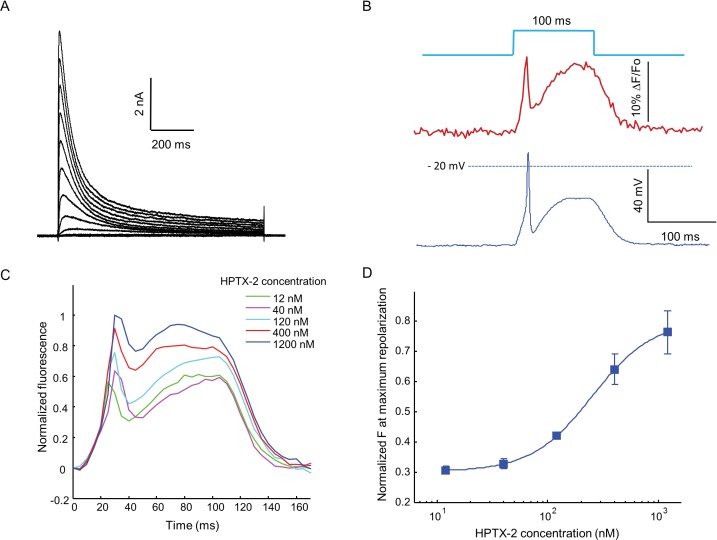
Optopatch assay of KV4.3 function.(A) Voltage clamp recording of KV4.3 current in NaV1.5-KV4.3 Optopatch HEK cells. The bath contained 30 μM TTX to block the NaV1.5 current. Cells were held at −70 mV and then subjected to 1 s steps to −60 mV to +40 mV in 10 mV increments. Peak KV4.3 current densities were 218 pA/pF. (B) NaV1.5-KV4.3-OS HEK cells were probed with simultaneous current clamp and QuasAr2 fluorescence. The cells were stimulated with a pulse of blue light (100 ms, 50 mW/cm2), and QuasAr2 fluorescence was monitored with 640 nm excitation, 400 W/cm2. KV activation led to a narrow action potential width, followed by KV inactivation and a return to steady-state depolarization. (C) Average QuasAr2 fluorescence traces from NaV1.5-KV4.3-OS HEK cells treated with HpTx-2 (n = 3–4 wells for each concentration). (D) Dose-response curve of HpTx-2 on NaV1.5-KV4.3-OS HEK cells. Drug effect was quantified by the fluorescence at the peak repolarization (~40 ms after onset of stimulus) relative to peak fluorescence intensity under 1200 nM HPTX2 treatment.